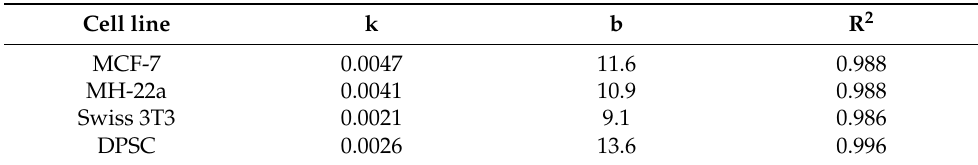
Table 1. Linear regression equation constants and model accuracy. Values have been determined